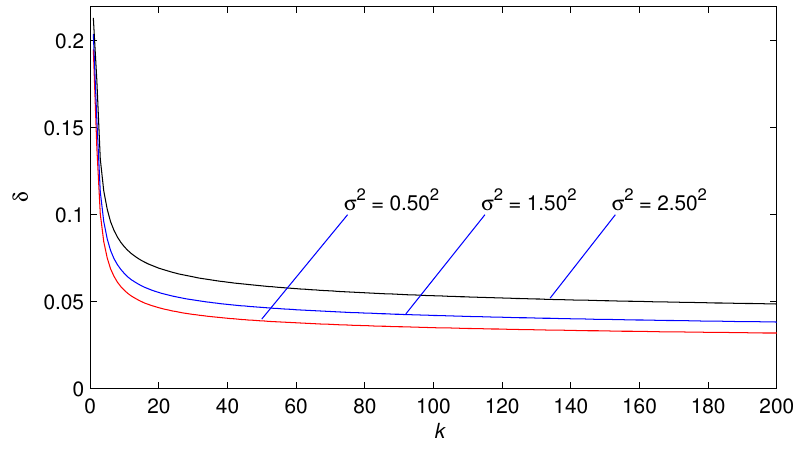
Figure 2. The NI estimation errors δ versus k .